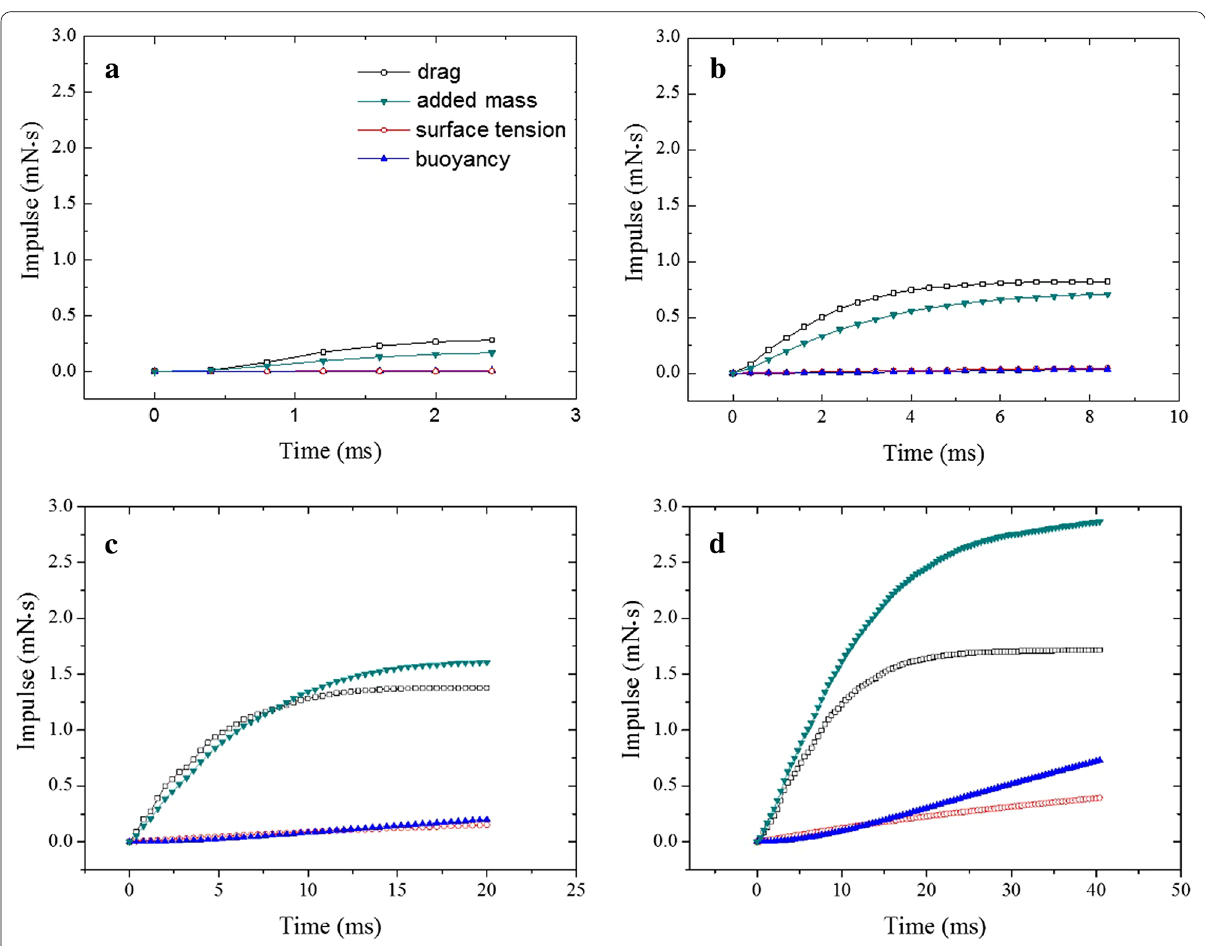
Fig. 6 The change of the magnitude of four impulse elements according to time for each rod length: a 2 cm, b 4 cm, c 6 cm, and d 8 cm